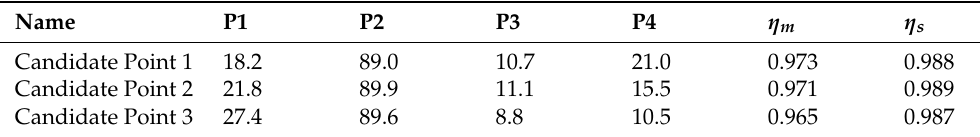
Table 5. Candidate points determined by the screening method.